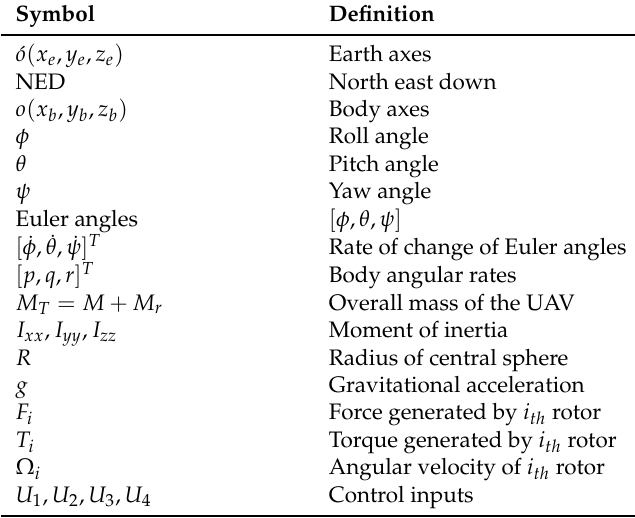
Table 1. List of